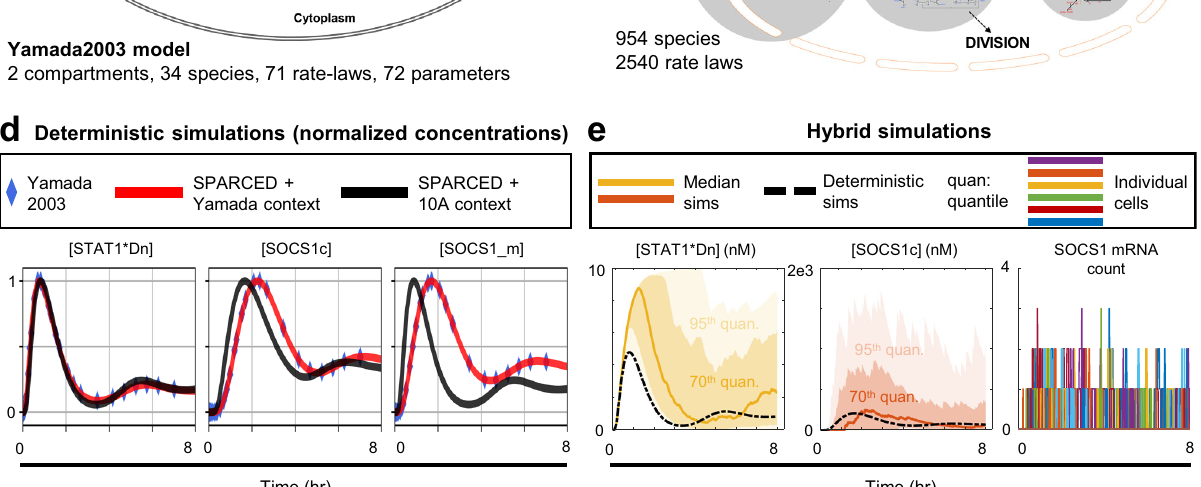
Fig. 4 SPARCED model is enlarged to include interferon-gamma (IFN γ ) signaling pathway. a Experiments showed that IFN γ treatment signi fi cantly decreases cell proliferation induced by EGF alone ( p -value = 1.86E-04). Fraction of EdU positive cells at 48 h after EGF alone or EGF + IFN γ treatment are calculated. Bars represent mean ± s.e.m. of three independent biological replicates. Signi fi cance tested using two-sided two-sample t -test, where *** p - value < 0.001. b Yamada2003 model schematic of IFN γ pathway added into SPARCED model. c Overview of the added IFN γ -IFNGR pathway in relation to the Bouhaddou2018 model pathways. The “ SOCS1 ” link is the candidate mechanism tested in the next section. d Simulations of the Yamada2003 model, SPARCED-I model, and SPARCED-I model with MCF10A context show qualitative and quantitative agreements. The Yamada2003 model results (blue diamonds) are obtained by running the model fi le in COPASI 61 . e 100 stochastic cell (hybrid) simulations (area plots) and the deterministic (dashed-black lines) simulation of 10 nM IFN γ stimulation are shown. Colored dark lines represent median cell trajectories, dark and light-colored regions represent 70th and 95th quantiles, respectively. The right-most plot shows mRNA count of SOCS1 in each cell, colored differently. Source data are provided in Source